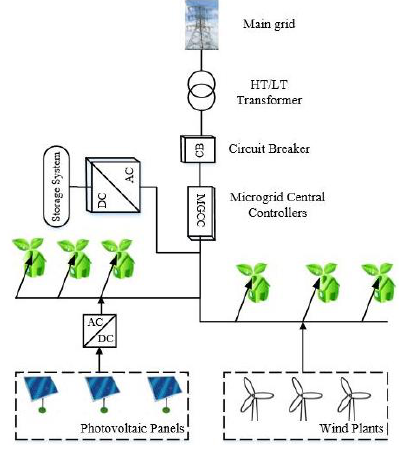
Figure 6. Micro grid system [75].